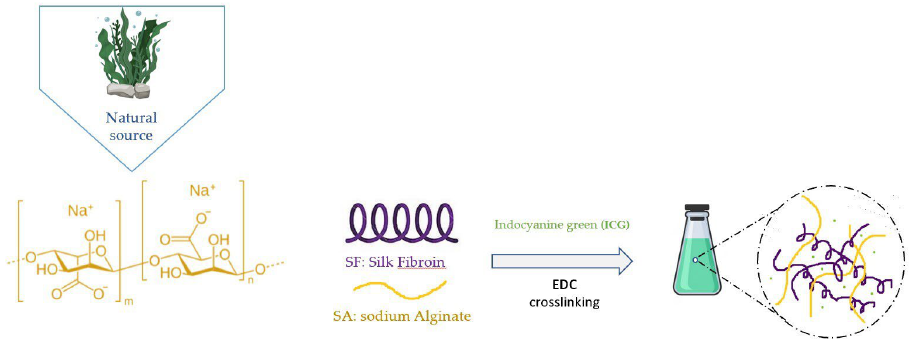
Figure 8. Alginate molecule and the synthesis of hydrogel by the addition of Silk Fibroin and crosslink1-ethyl-3-(3-dimethylaminopropyl) carbodiimide (EDC) [157].